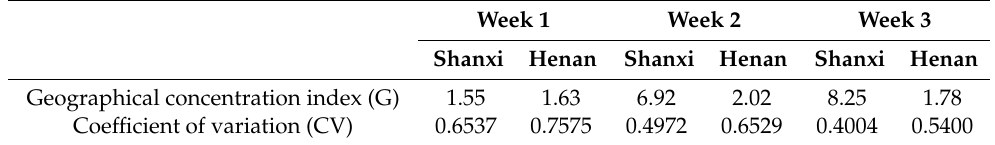
Table 1. Differences between regions in terms of internet attention to the torrential rain in Shanxi and Henan. Week 1 Week 2 Shanxi Henan Shanxi